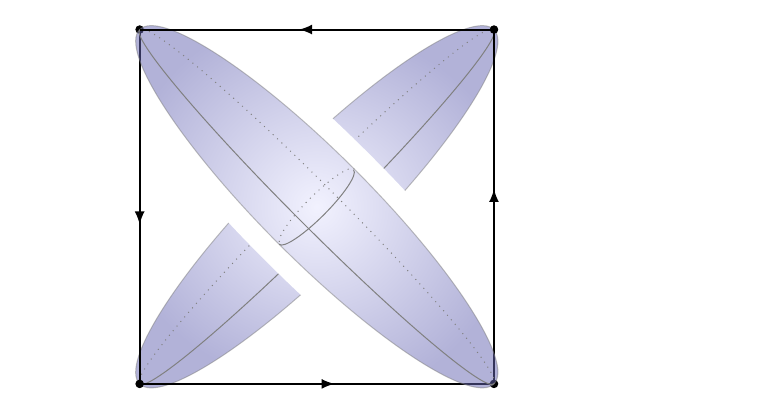
Figure 7 . These (cid:12)gures represent the NG boson that arises on the domain wall connecting the vacuum at the north pole with the vacuum at the south pole. The (cid:12)rst (cid:12)gure is the NG boson on the domain wall and the second and third (cid:12)gures represent the bulk vacua.